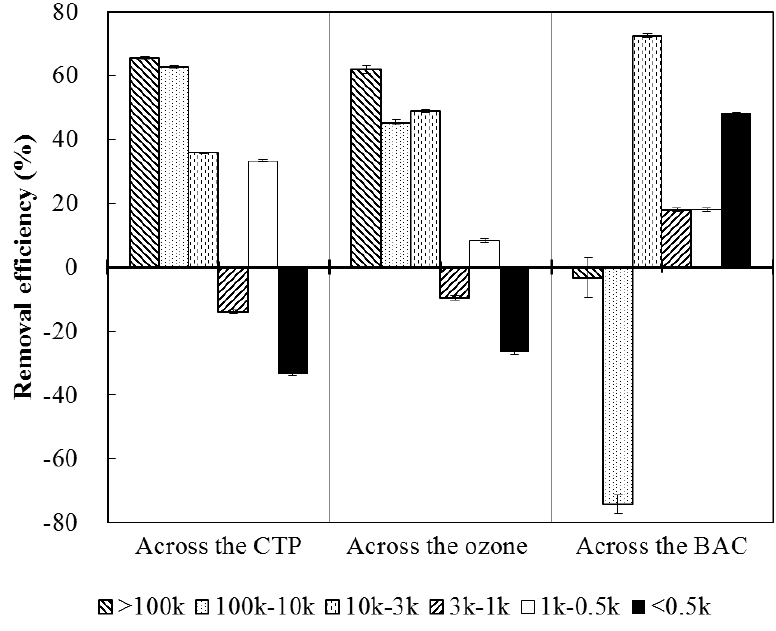
Figure 4. Removal efficiencies of the DOC at different molecular fraction groups across the CTP, ozone and BAC (the removal efficiencies of DOC at different MW fraction groups were compared to the previous treatment unit; the presented data in the figure are the average of the observations (n = 3), the error bars represent the standard deviation of replicate